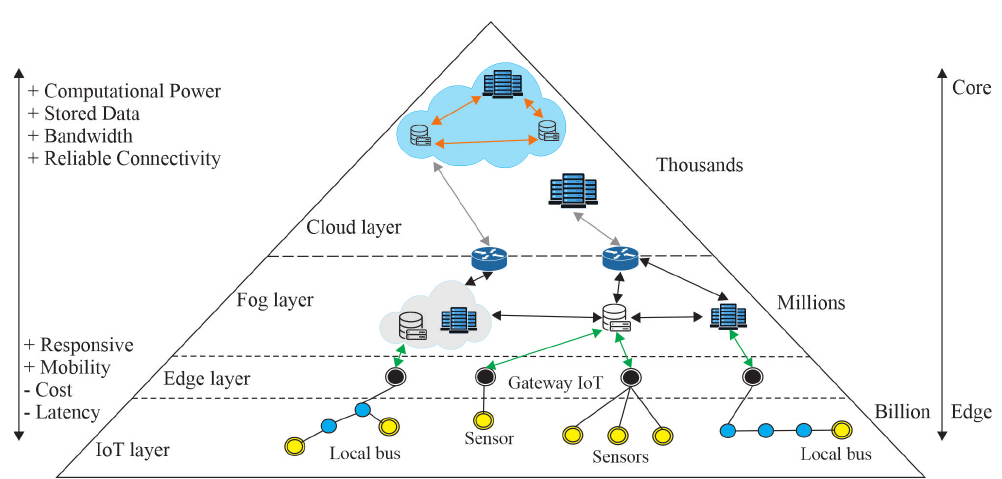
Figure 1. Conceptual Model of Communication Architecture. Adapted: